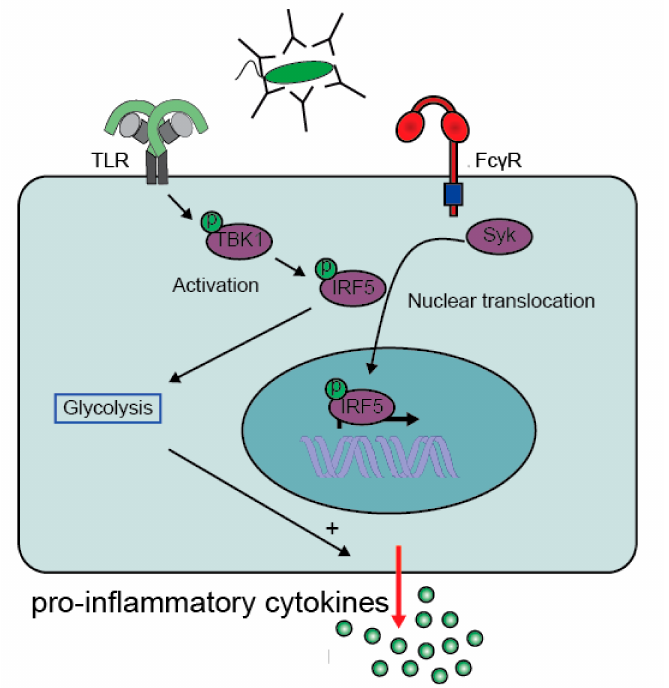
Figure 3. Fc γ R-TLR cross-talk converges on IRF5 activation. TLR activation mediates activation (phosphorylation) of IRF5 via activation of TBK1. Meanwhile, activation of Fc γ RIIa by IgG-immune complexes promotes translocation of the activated IRF5 to the nucleus. IRF5 is not only a tran- scription factor that increases gene transcription of pro-inflammatory genes, but also promotes glycolytic changes that enhances gene translation. Abbreviations: TBK1, TANK-binding kinase 1; IRF5, Interferon regulatory factor 5. (Modified figure from Hoepel et al.